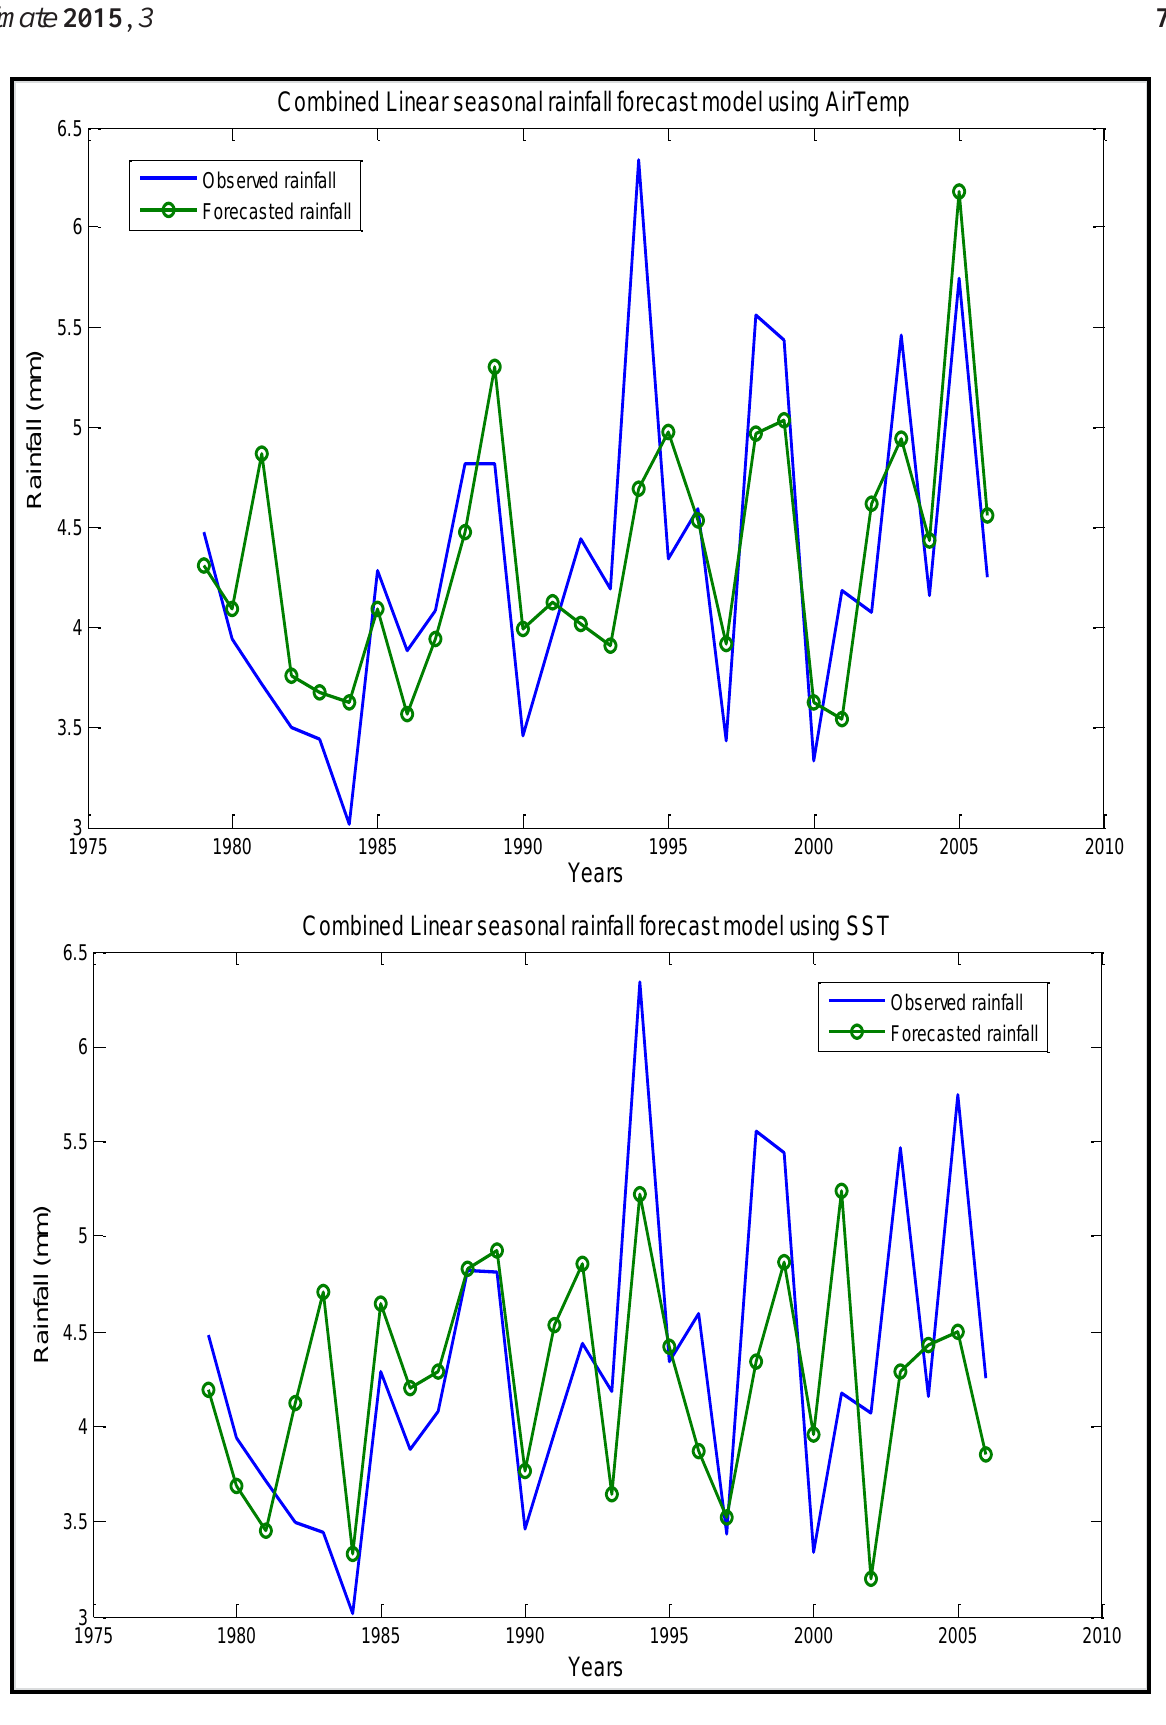
Figure 7. Combined linear model for seasonal rainfall forecast using AirTemp (upper panel) and SST (lower